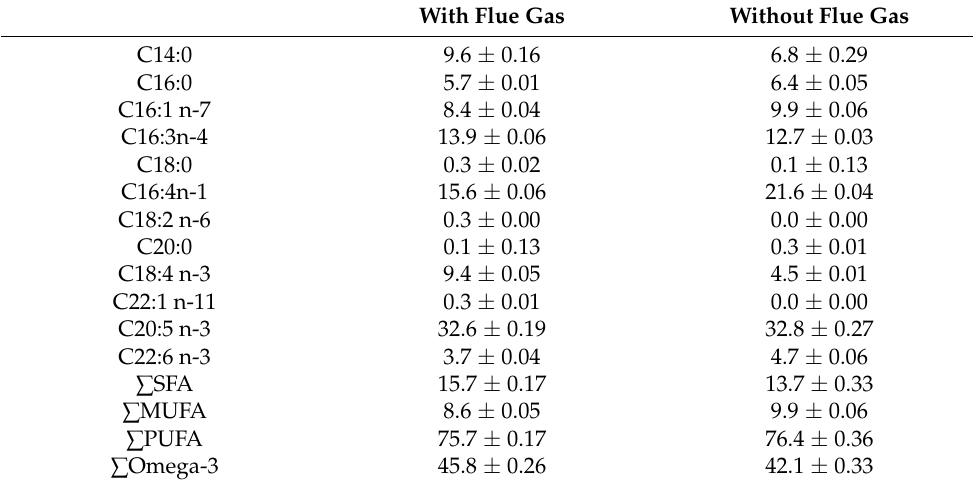
Table 8. Fatty acid composition (%, average ± SD, n = 5) of the diatom cultivated with and without factory flue gas.